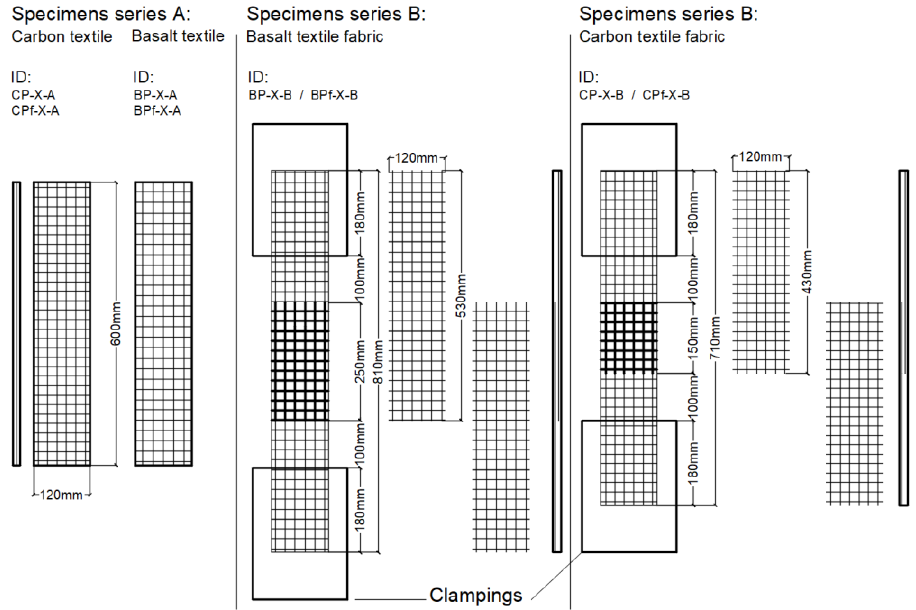
Figure 1. Details of the design for specimens of series A and series B.